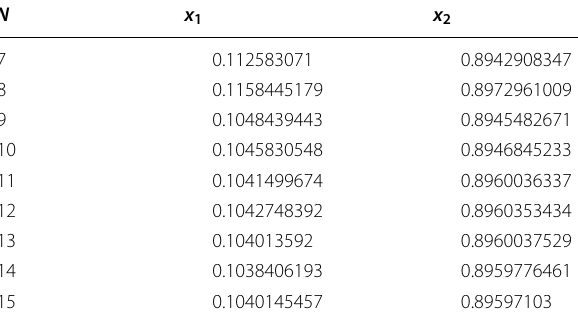
Table 11 Lift-off points x 1 and x 2 at q = q 4 for various N